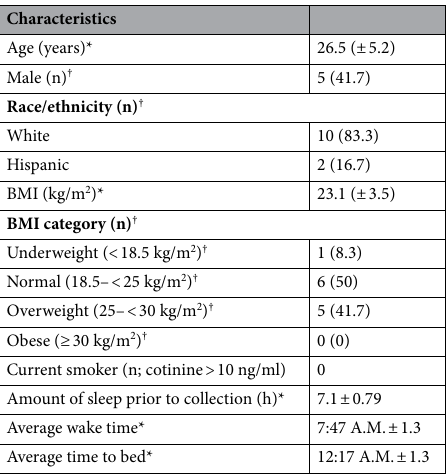
Table 1. Subject characteristics (n = 12). *Data presented as mean ± SD. † Data presented as number